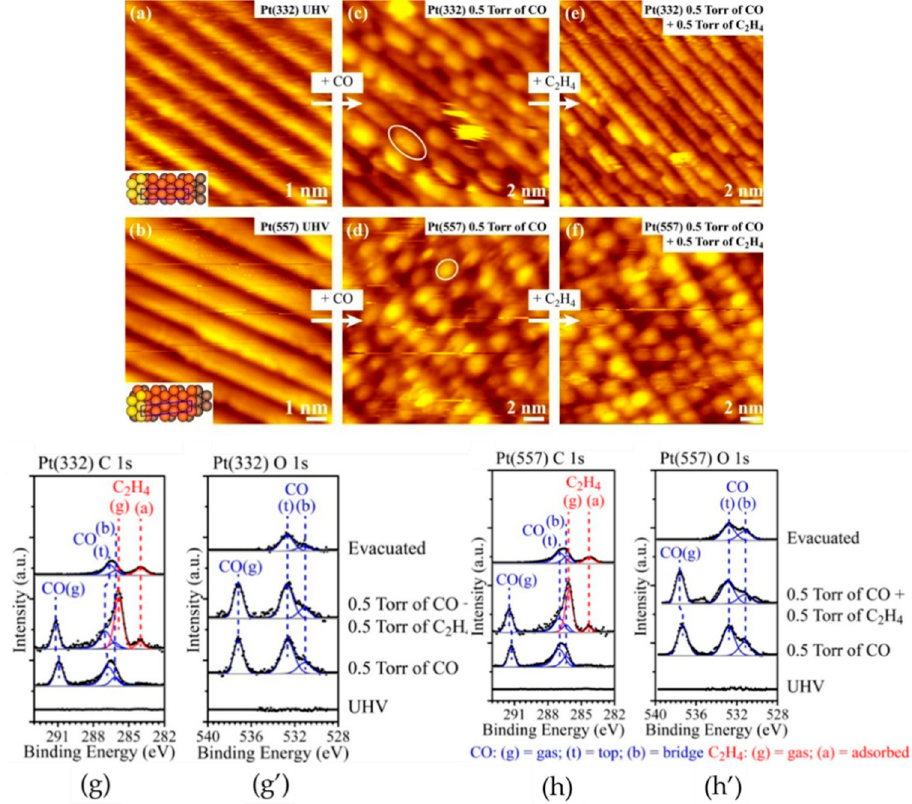
Figure 8. STM images of the Pt(332) surface ( a ) in ultra-high-vacuum (UHV). ( c ) Formation of clusters on Pt(332) in the presence of 0.5 Torr CO. ( e ) Clusters gradually disappear after addition of 0.5 Torr of C 2 H 4 , similar images are shown in ( b , d , f ) on the Pt(557) surface. Two clusters in each ( c ) and ( d ) are highlighted by a white ellipse as examples. The same AP-XPS experimental data are shown in the right panel. ( g , h ) C 1s spectra of Pt(332) and Pt(557) after adding CO and subsequently C 2 H 4 , and ( g’ , h’ ) corresponding O 1s spectra of Pt(332) and Pt(557). From bottom to top: in UHV, under 0.5 Torr of CO, under 0.5 Torr of CO + 0.5 Torr of C 2 H 4 , evacuated to 10 − 8 Torr.